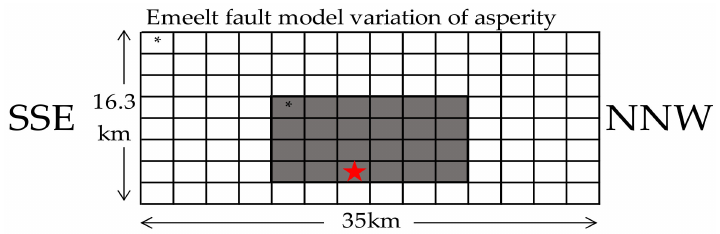
Figure 12. Characterized variations of the Emeelt fault model. Grids represent the sub-faults of the earthquake. The dark area indicates the asperity area in the fault. Asterisks and stars represent the origins of the background and the asperity, and the rupture starting point, respectively.